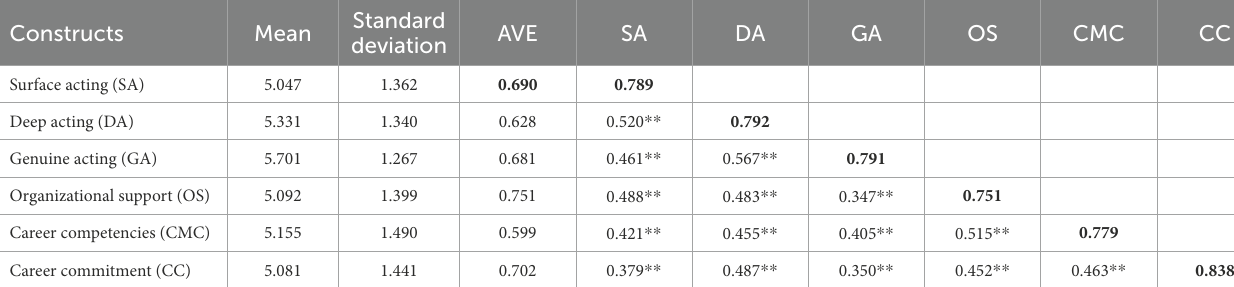
TABLE 2 Correlation and discriminant validity. Constructs